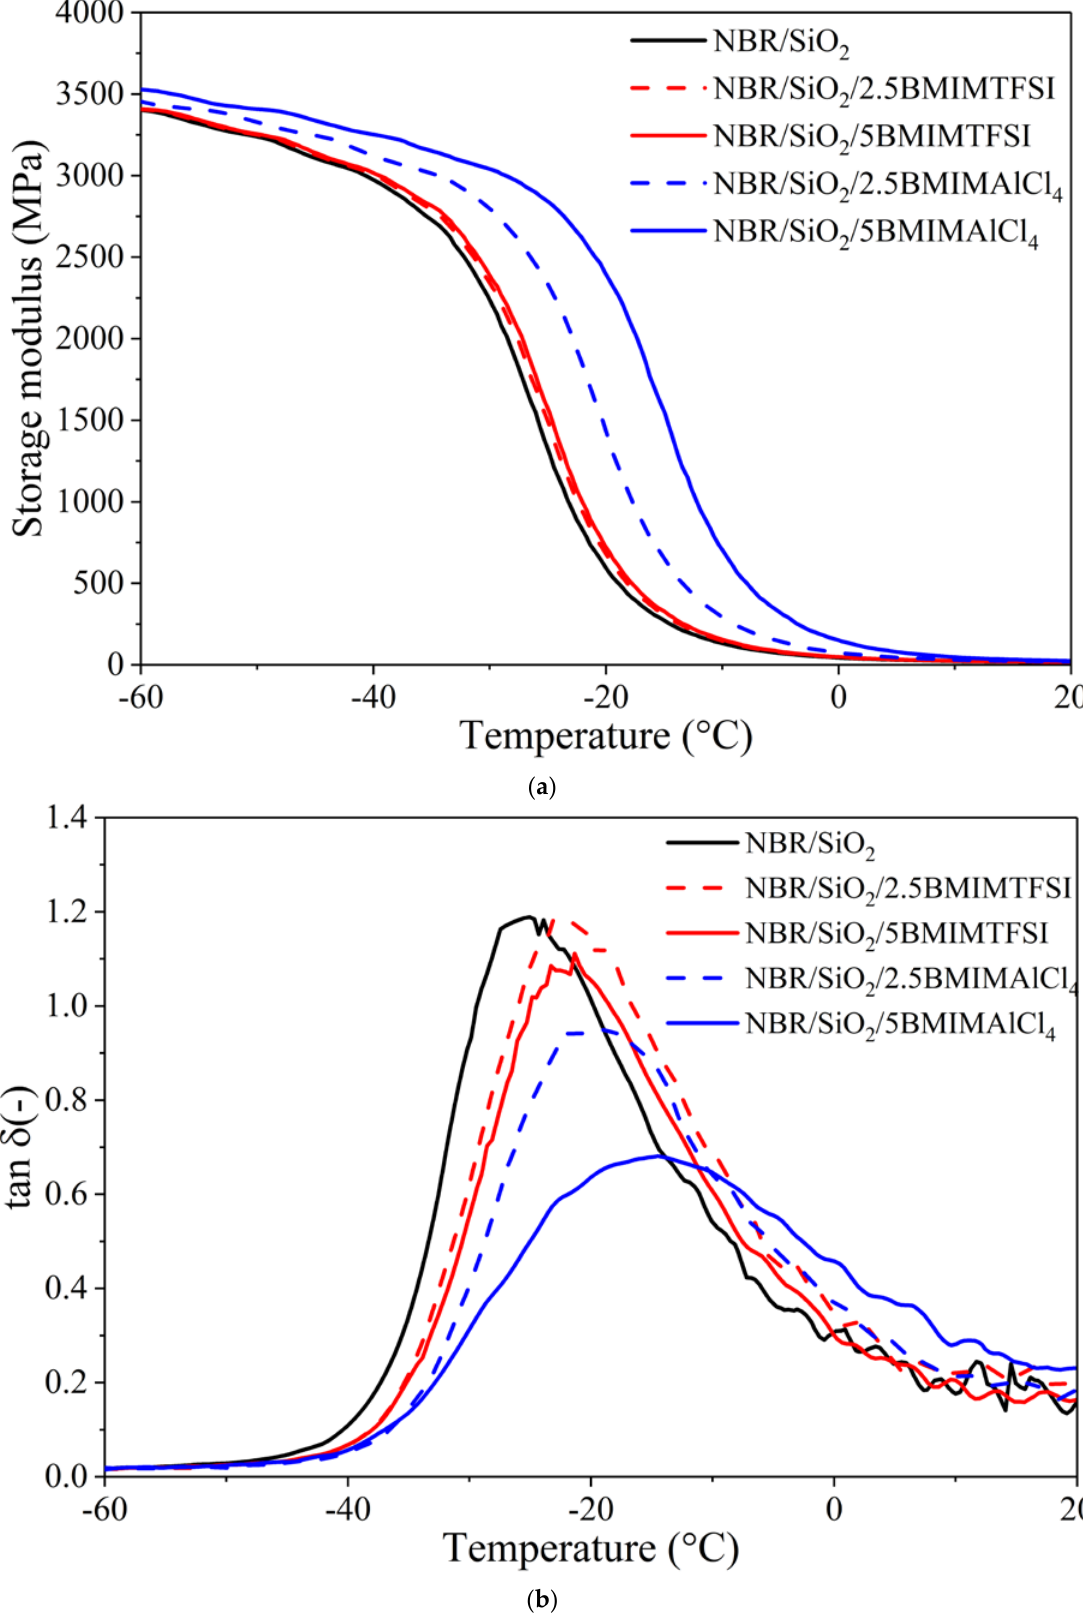
Figure 7 . Storage modulus ( a ) and tanδ ( b ) values versus temperature curves for NBR/SiO 2 Figure 7. Storage modulus ( a ) and tan δ ( b ) values versus temperature curves for NBR / SiO 2 composites composites containing ionic liquids. containing ionic